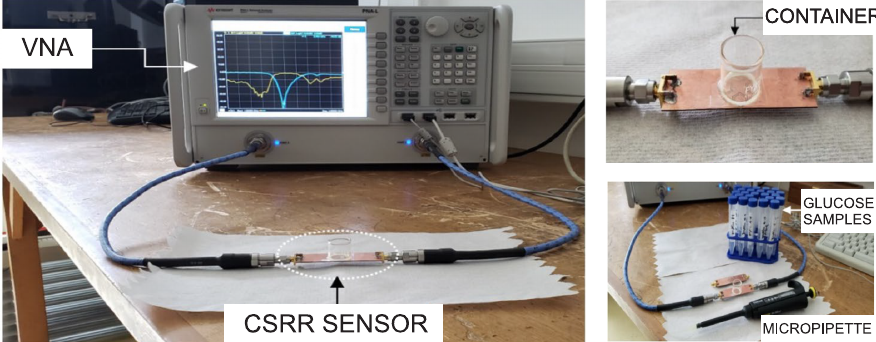
Figure 11. Glucose-sensing experiments: VNA experimental setup, sensor loaded with an empty container and the micropipette and glucose aqueous solutions used in the experiments. Reprinted with permission from Ref.